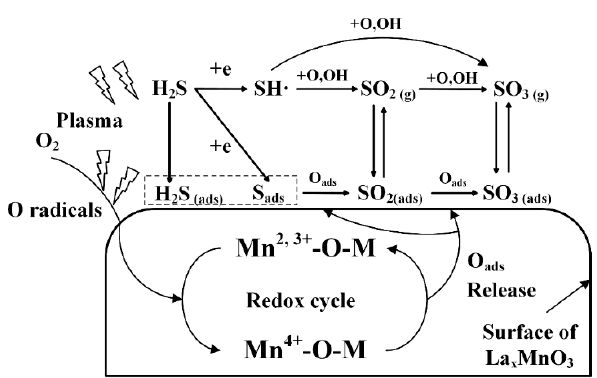
Figure 5. Reaction mechanisms of plasma-catalytic removal of H 2 S over the La x MnO 3 catalysts.